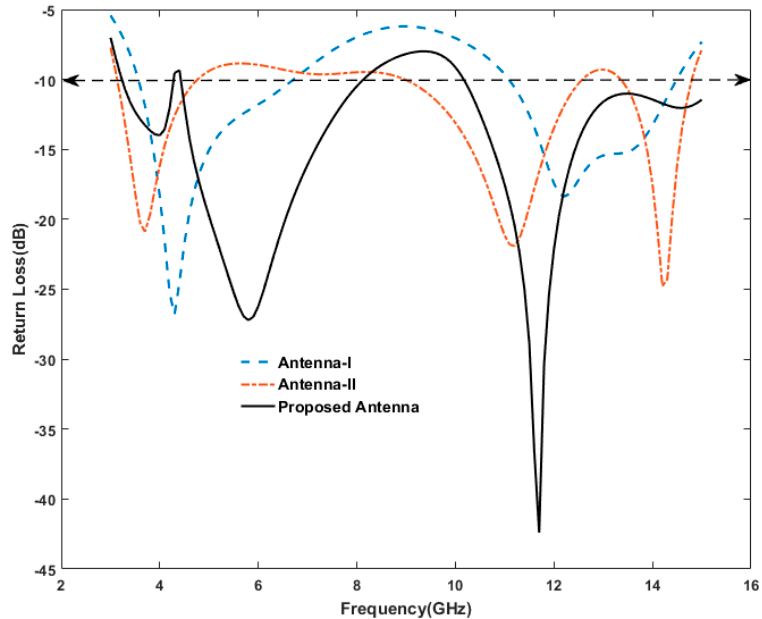
Figure 6. Comparison of simulated return loss of Antenna I, Antenna II and the proposed antenna.